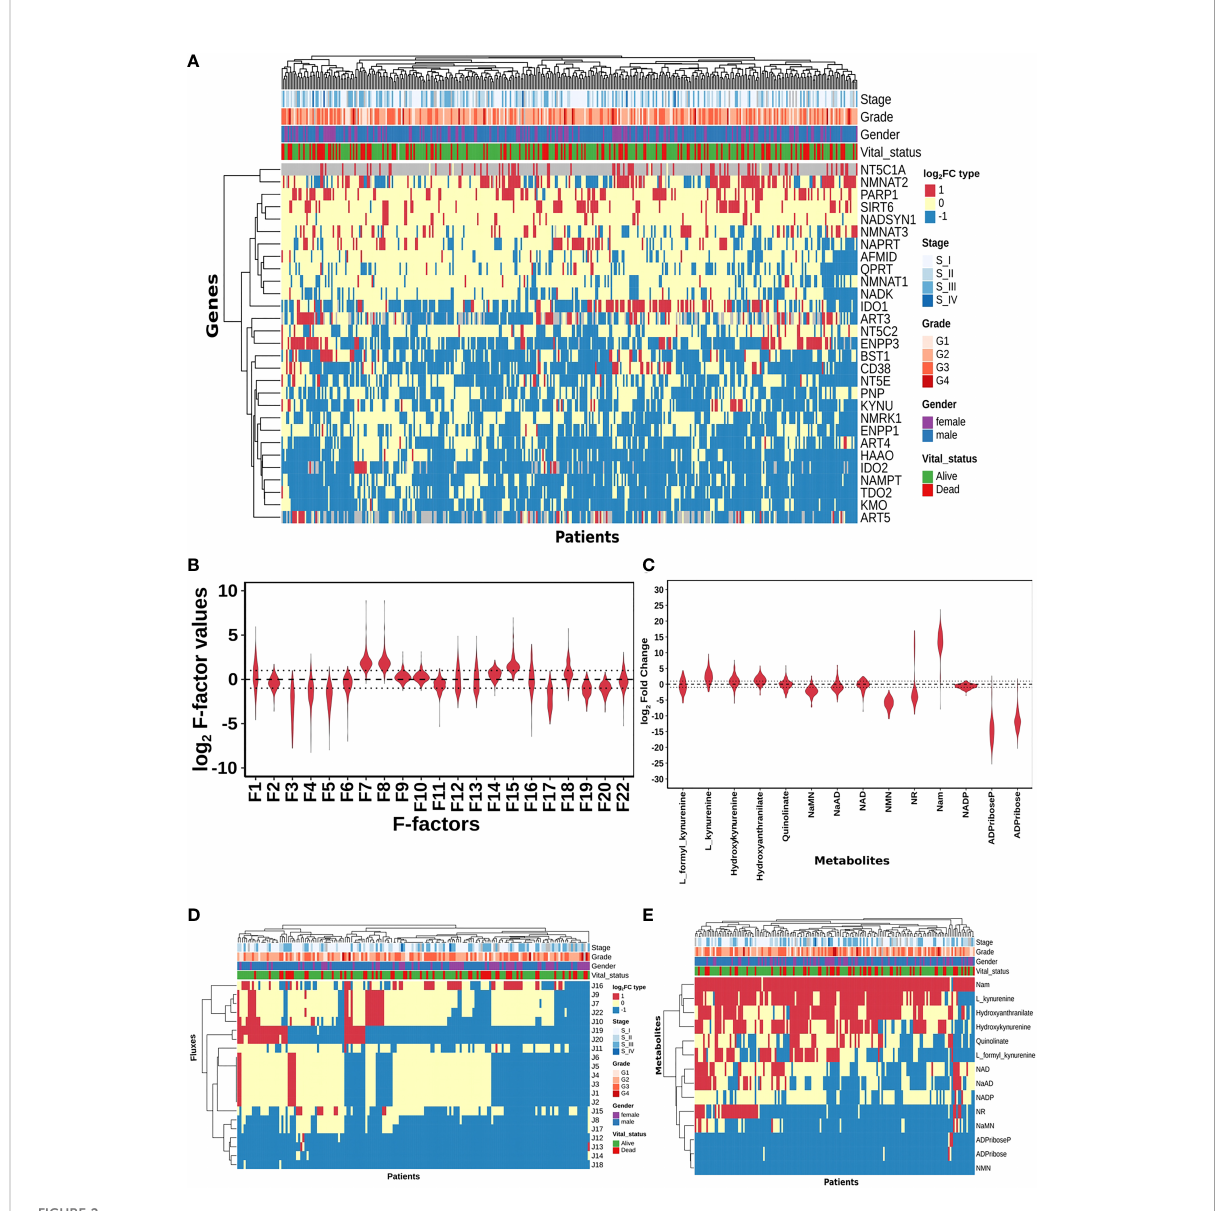
FIGURE 2 HCC patients exhibit heterogeneity in their NAD pro fi les. (A) Heatmap of NAD net genes log 2 FC values in tumour tissue calculated with respect to the normal tissue, rows correspond to genes (n = 29) and columns correspond to patients (n = 371). The red colour represents the upregulation of gene expression in tumour tissue compared to the normal tissue (log 2 FC ≥ +1), the blue colour represents a downregulation of gene expression in tumour tissue compared to the normal tissue (log 2 FC ≤ -1), yellow colour represents no change of gene expression in tumour tissue compared to the normal tissue (-1 < log 2 FC < +1). Rows and columns are arranged based on the complete hierarchical clustering method. Annotations on the top of the heatmap are Stage, Grade, Gender, and Vital status (refer to the key in the image for more details). (B) Violin plot of log 2 F-factor values of NAD net model. The X-axis shows the F-factors and the Y-axis shows the log 2 (fold change) values. (C) Violin plot of log 2 FC values of NAD net metabolites. The X-axis shows the Genes, and the Y-axis shows the log 2 (fold change) values. Metabolites are arranged according to the routes mentioned in Figure 1A. (D) Heatmap of reaction Fluxes obtained after steady-state analysis, rows correspond to reaction fl ux (n = 21), and columns correspond to patients (n = 168). The red colour represents an increase in fl ux compared to the base model, the blue colour represents a decrease in fl ux compared to the base model, and the yellow colour represents no change in fl ux compared to the base model. Rows and columns are arranged based on the complete hierarchical clustering method. Annotations on the top of the heatmap are Stage, Grade, Gender, and Vital status (refer to the key in the image for more details). (E) Heatmap of Metabolites obtained after steady-state analysis, rows correspond to metabolites and columns correspond to patients (n=168). The red colour represents an increase in the concentration of metabolite compared to the base model, the blue colour represents a decrease in the concentration of metabolite compared to the base model, yellow colour represents no change in concentration of metabolite compared to the base model. Rows and columns are arranged based on the complete hierarchical clustering method. Annotations on the top of the heatmap are Stage, Grade, Gender, and Vital status (refer to the key in the image for more